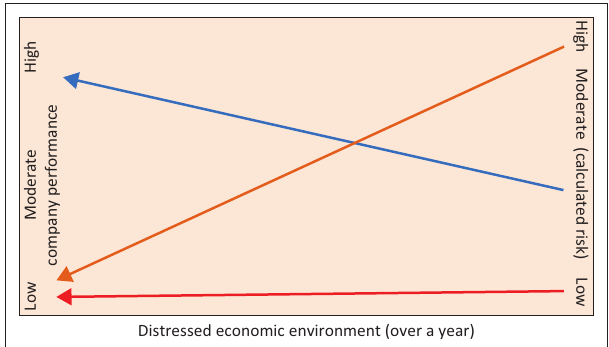
FIGURE 2: A proposed risk-performance